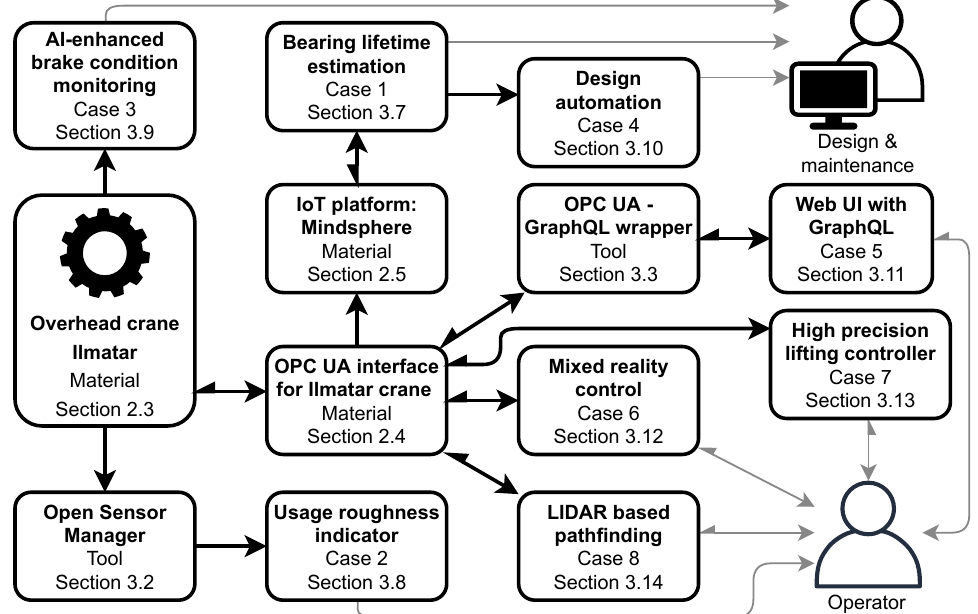
Figure 1. Overview of the digital twin components developed for the overhead crane. The black arrows depict data flow through a technical Application Programming Interface (API) and gray arrows are human-machine interfaces. The full arrowhead depicts primary information flow and half arrowhead secondary information flow, such as control. Each component is further described in the mentioned section and the APIs are further described in Section